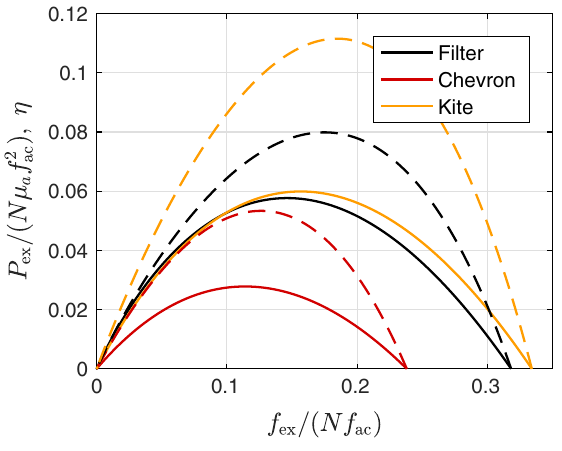
FIG. 6. Output power (solid curves) and active efficiency (dashed curves) as a function of the external force f velocity filter (black curves), chevron (red curves), and kite (orange curves) from Fig. 4 in the mean-field limit of many active particles with large persistence.